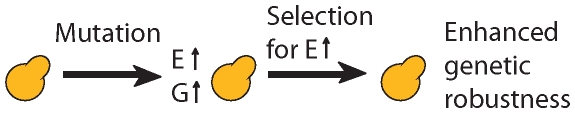
A model for the evolution of mutational robustness.The coupling between the requirement of genes for genetic (‘G’) and environmental (‘E’) robustness means that during evolution, selection for adaptive increases in environmental resilience may often have the side-effect of increasing mutational robustness.